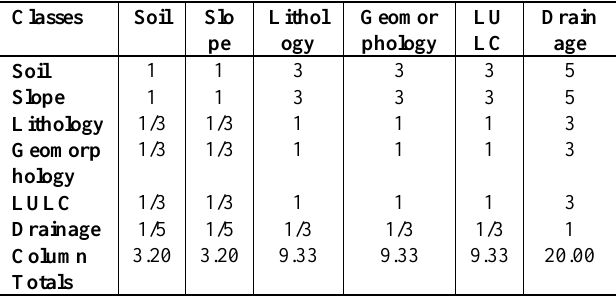
Table 9. Pair wise Comparison